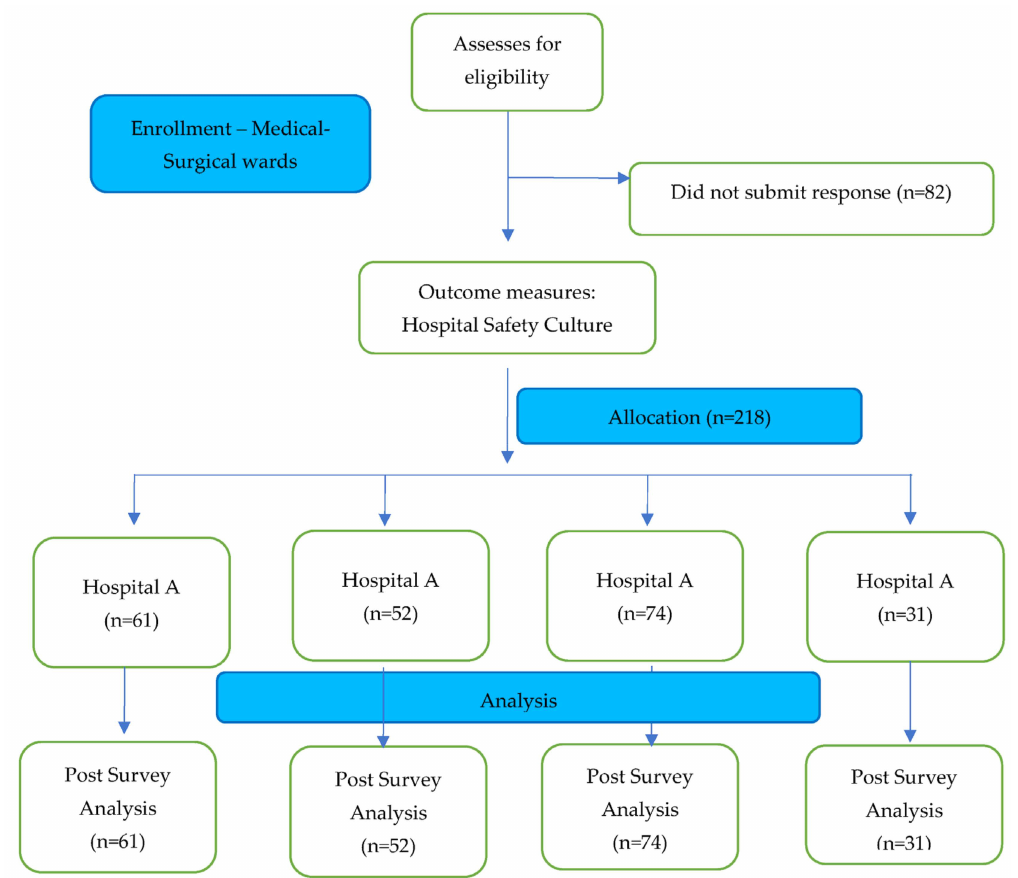
Figure 1. Flowchart representation of the